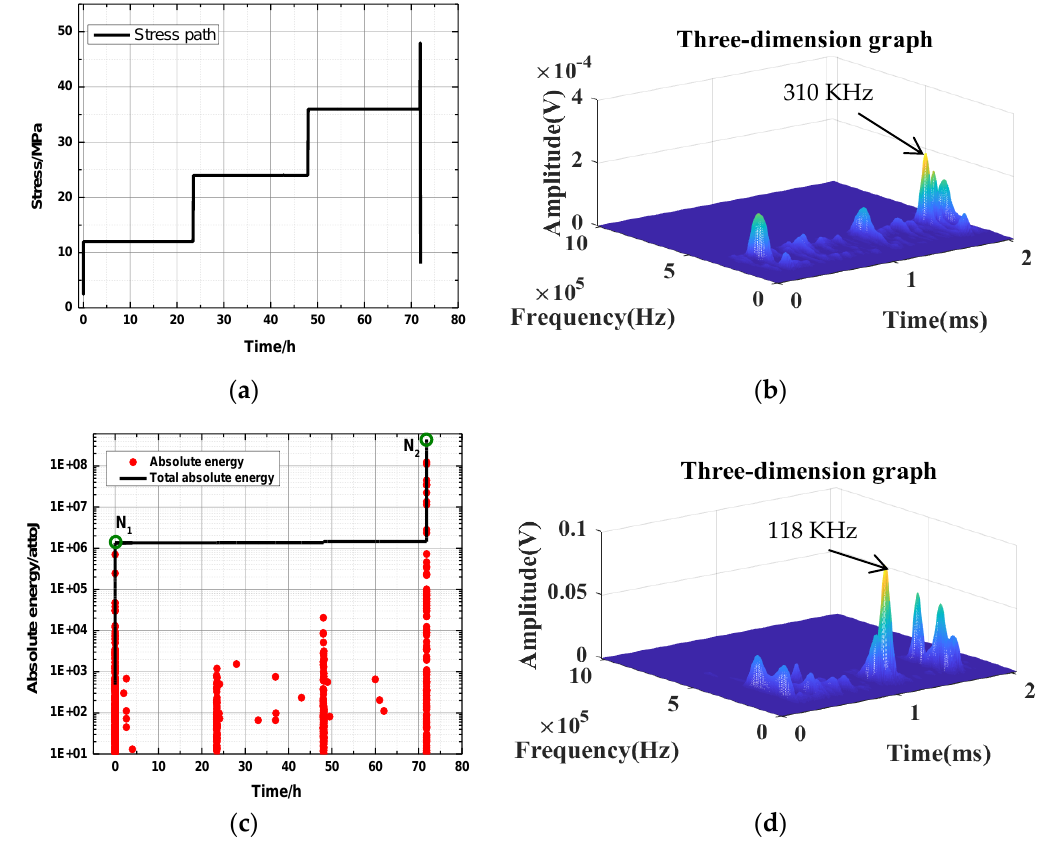
Figure 10. Stress with time for the 45 bedding angle under natural state: ( a ) the actual stress path; and ( c ) the corresponding acoustic emission energy curve. Images ( b , d ) are the waveform characteristics of key points.